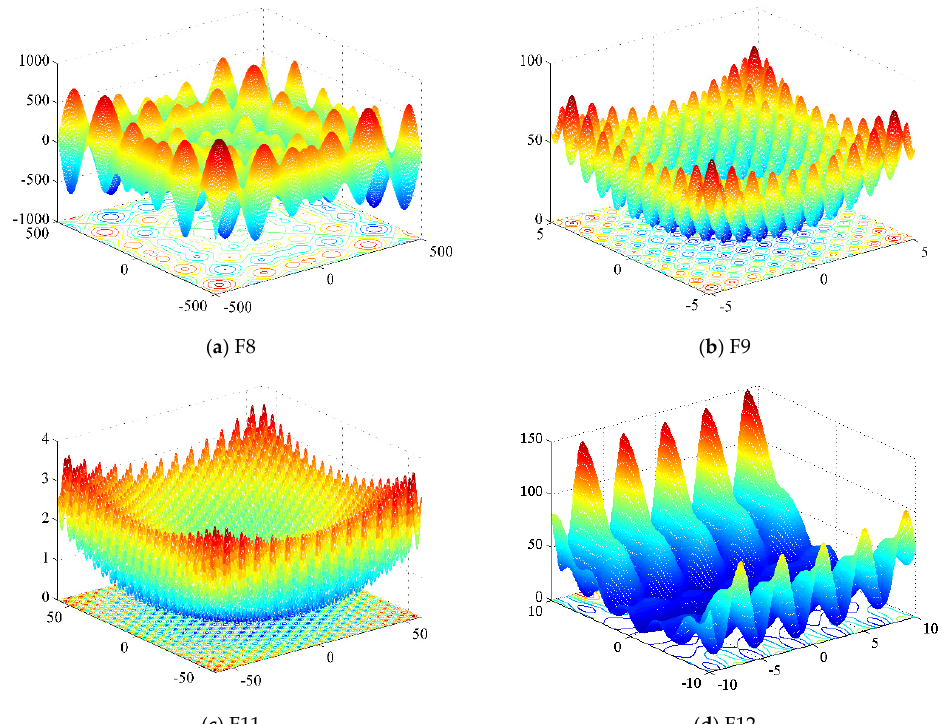
Figure A1. 2-Dimensional forms of the multimodal functions.